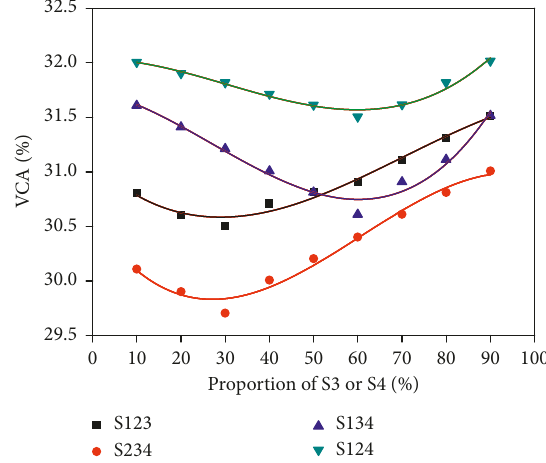
Figure 20: Influence of the content of secondary aggregates on the